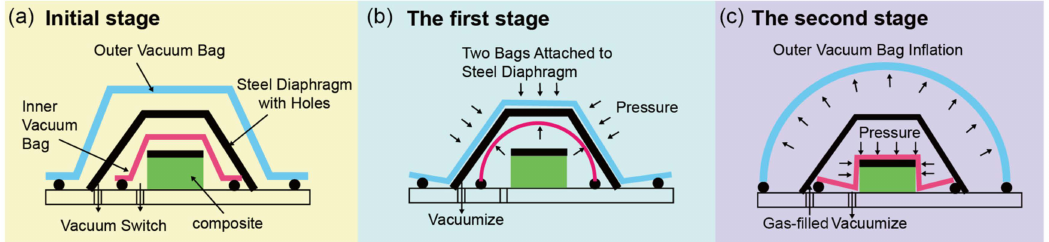
Figure 5. DVB derived from OoA [78]. ( a ) Initial stage; ( b ) the first stage, as two bags are attached to steel diaphragm; and ( c ) the second stage, as gas is filled between two